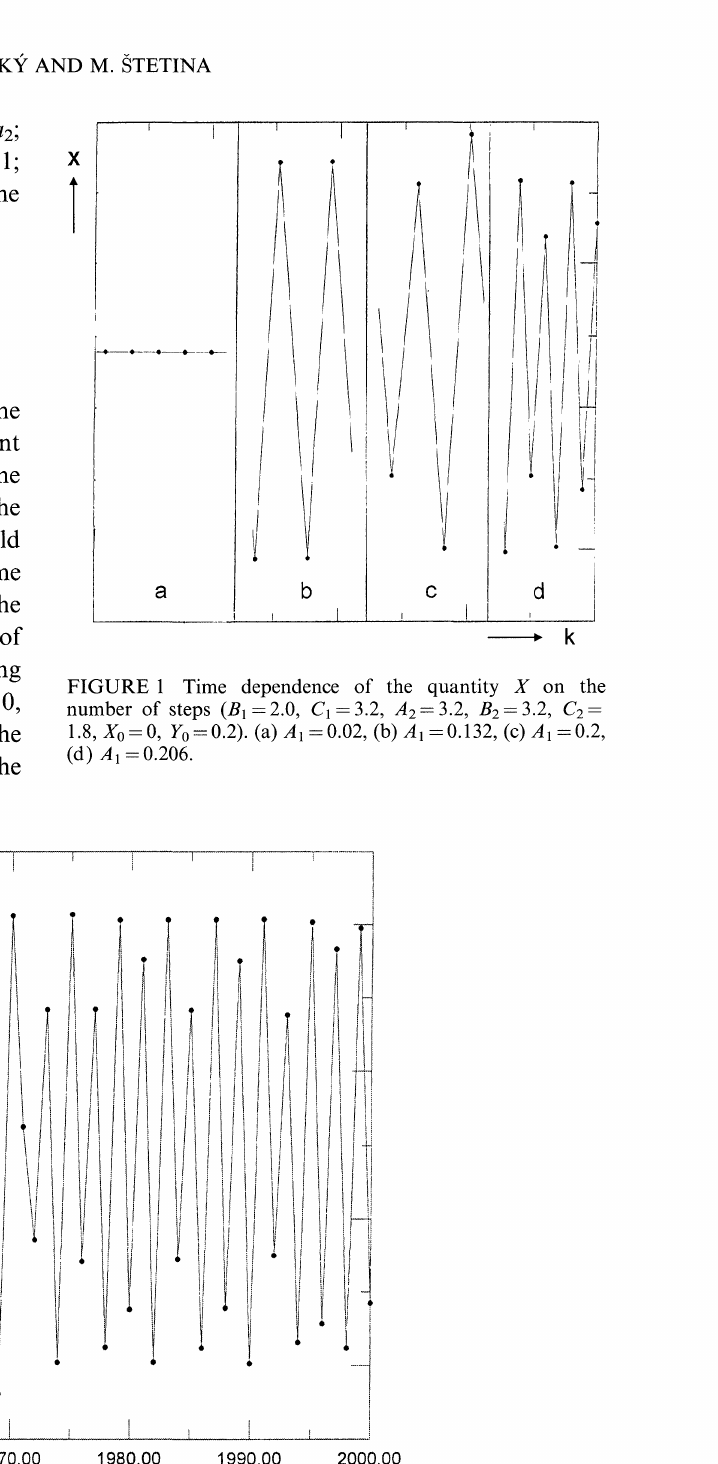
FIGURE 2 Time dependence of the quantity X for last 50 steps belonging to the value A1 =0.23 demonstrating the deterministic chaos (last constants as in Fig.